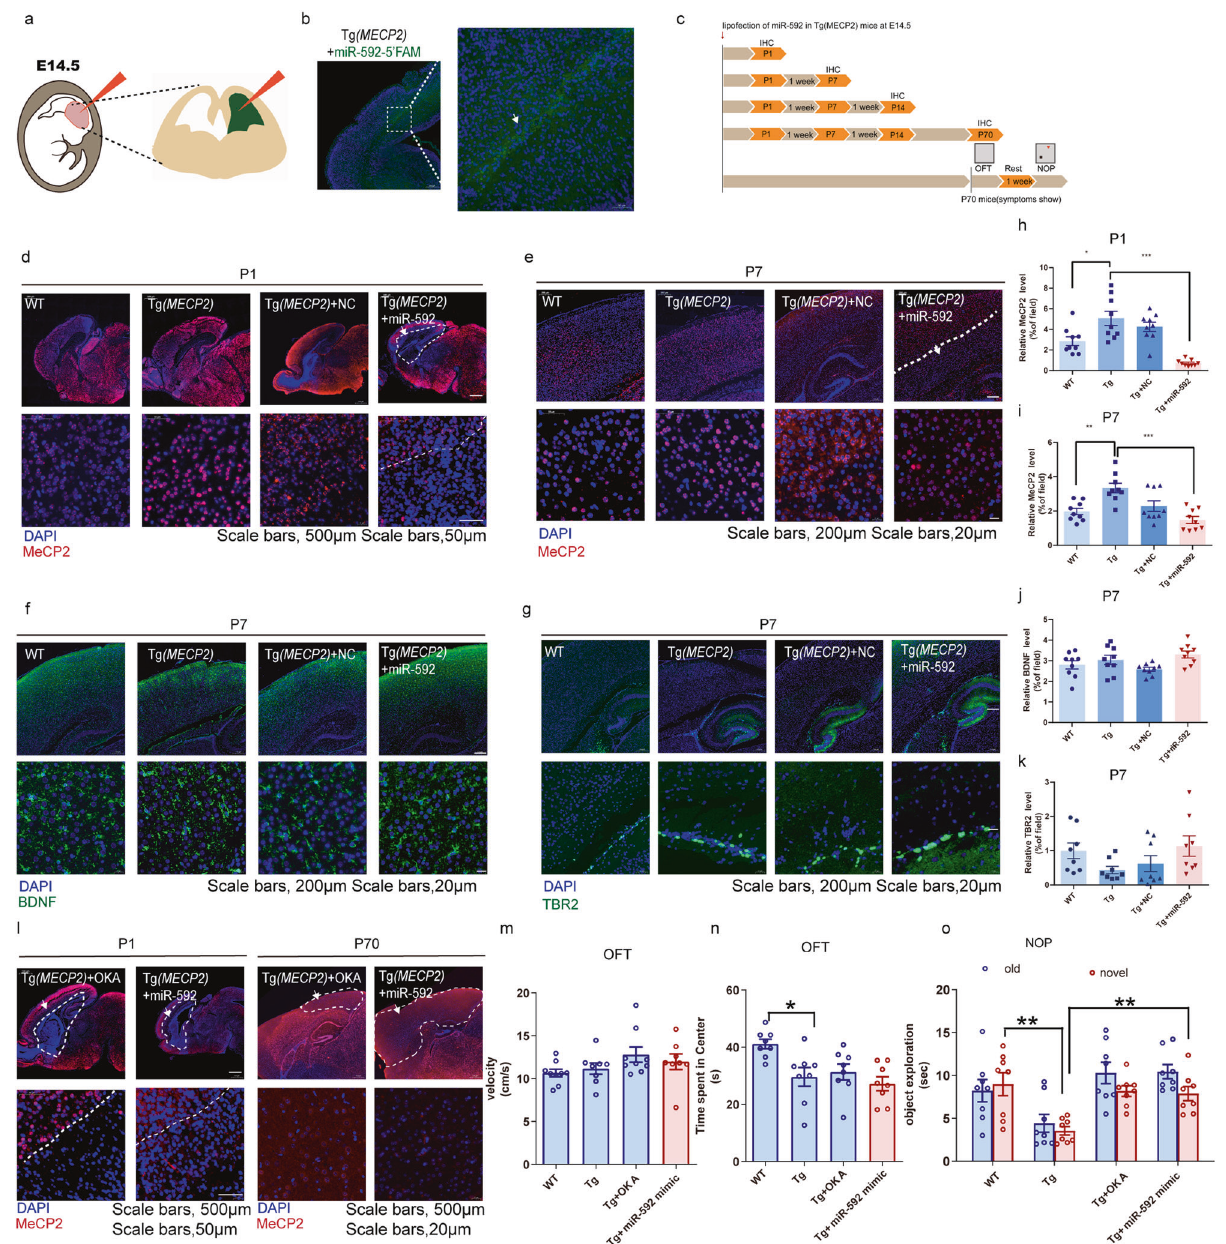
Fig. 6 Phenotype reversal in Tg( MECP2 ) mice using miR-592. a Schematics of the LNA experiment in utero. Brains were injected with Lipofectamine/miR-592 mimic at E14.5. The injected side (visualized by adding fast green to the LNA mixture) was compared to the contralateral uninjected side. b Brains were injected with Lipofectamine/miR-592 – 5 ’ FAM at E14.5. c Timeline of miR-592 mimic treatment, immuno fl uorescence and behavioural tests. d – k Immuno fl uorescence showing the MeCP2 response to miR-592 mimic treatment at d P1 and e P7. f BDNF staining (green immuno fl uorescence), g TBR2 staining (green immuno fl uorescence), and DAPI (blue fl uorescence). h – k Quanti fi ed fl uorescence intensity data are shown in the bar graph. h Quanti fi cation of MeCP2 expression by immuno fl uorescence at P1. i Quanti fi cation of MeCP2 expression by immuno fl uorescence at P7. j Quanti fi cation of BDNF expression by immuno fl uorescence at P7. k Quanti fi cation of TBR2 expression by immuno fl uorescence at P7. The averages of nine different fi elds of view were calculated for each animal (counts from three fi elds of view/ sagittal slice). l Immuno fl uorescence showing the MeCP2 response to miR-592 mimic and OKA treatment at P1 and P70 (one-way ANOVA with Tukey ’ s multiple comparison test, error bars represent S.E.M.). The averages of nine different fi elds of view were calculated for each animal (counts from three fi elds of view/ sagittal slice). m OFT open fi eld test. The velocities of 70-day-old WT and Tg ( MECP2 ) mice (12 weeks after OKA and miR-592 mimic treatment) were recorded (one-way ANOVA with Tukey ’ s multiple comparison test, n = 8, error bars represent S.E.M.). n OFT open fi eld test. The time spent in the centre was recorded for 70-day-old WT and Tg( MECP2 ) mice (12 weeks after OKA and miR-592 mimic treatment) (one-way ANOVA with Tukey ’ s multiple comparison test, n = 8, error bars represent S.E.M.). o NOP novel object preference test. The curiosity behaviour of 70-day-old WT and Tg( MECP2 ) mice (12 weeks after OKA and miR-592 mimic treatment) was tested (two-way ANOVA with Tukey ’ s multiple comparison test, n = 8, error bars represent S.E.M.). * p < 0.05, ** p < 0.01, *** p <